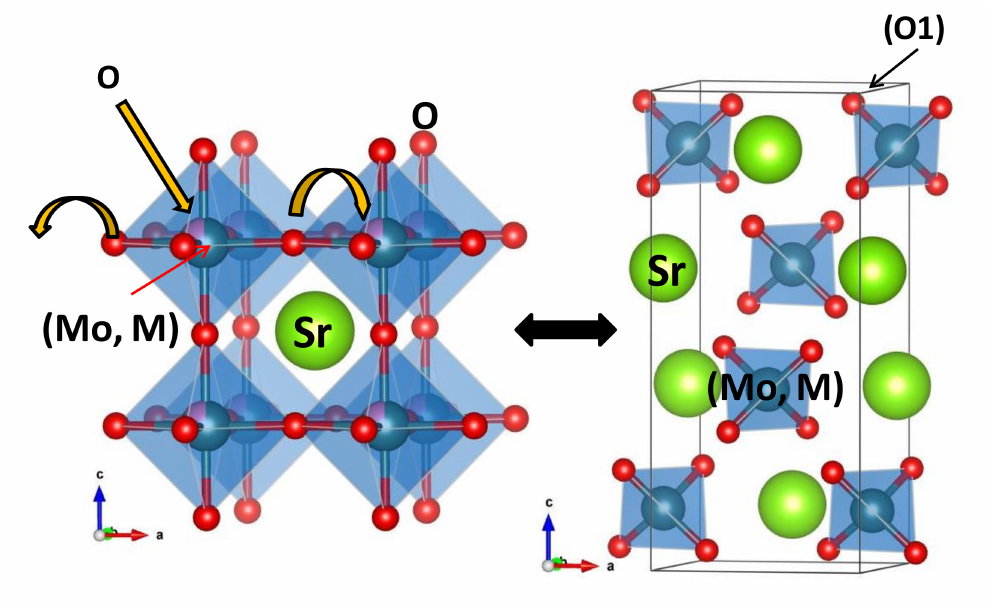
Figure 7. Perovskite and scheelite structures for SrMo 1 − x M x O 4 − δ (M = Fe and Cr). Figure6bshowsaprojectionofthescheelitestructureonthe(0:1:0)plane,